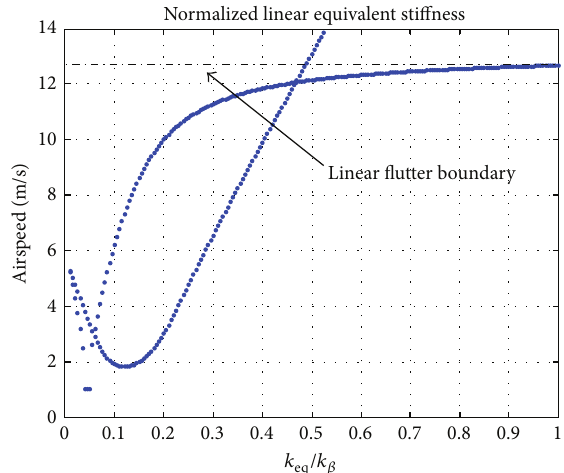
Figure 8: Linear equivalent stiffness from the HBM.